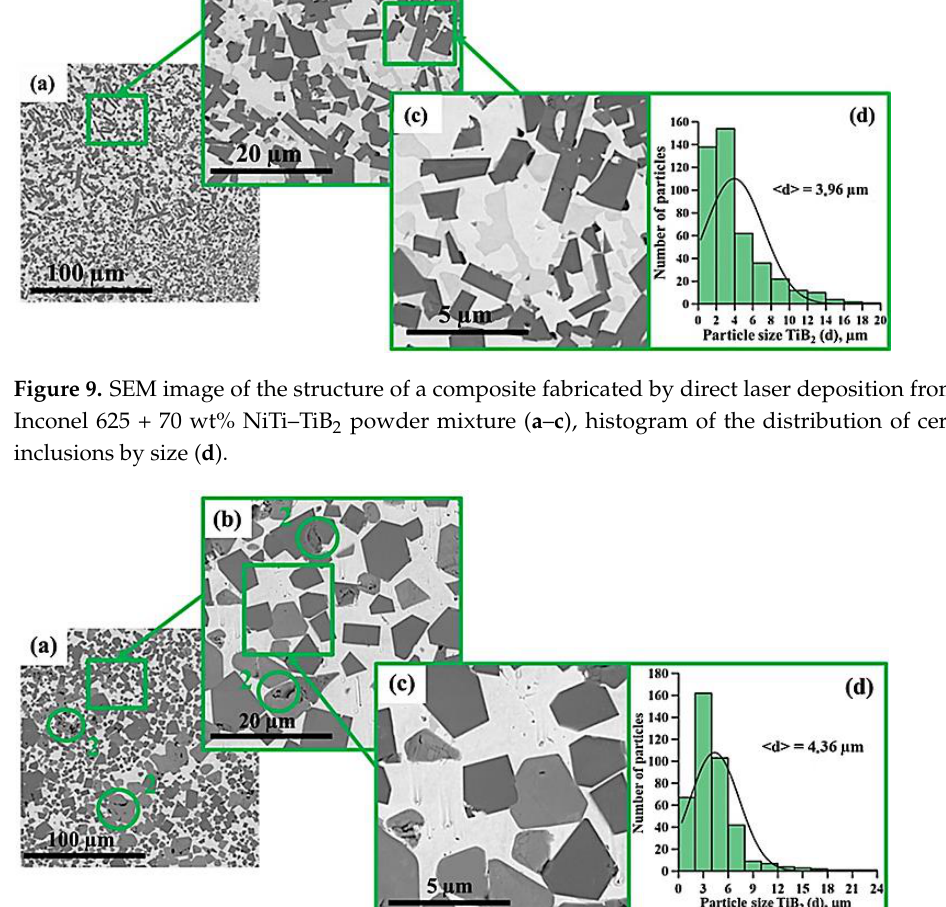
Figure 10. SEM image of the structure of a composite fabricated by direct laser deposition from the Inconel 625 + 90 wt% NiTi–TiB 2 powder mixture ( a – c ), histogram of the distribution of ceramic inclusions by size ( d